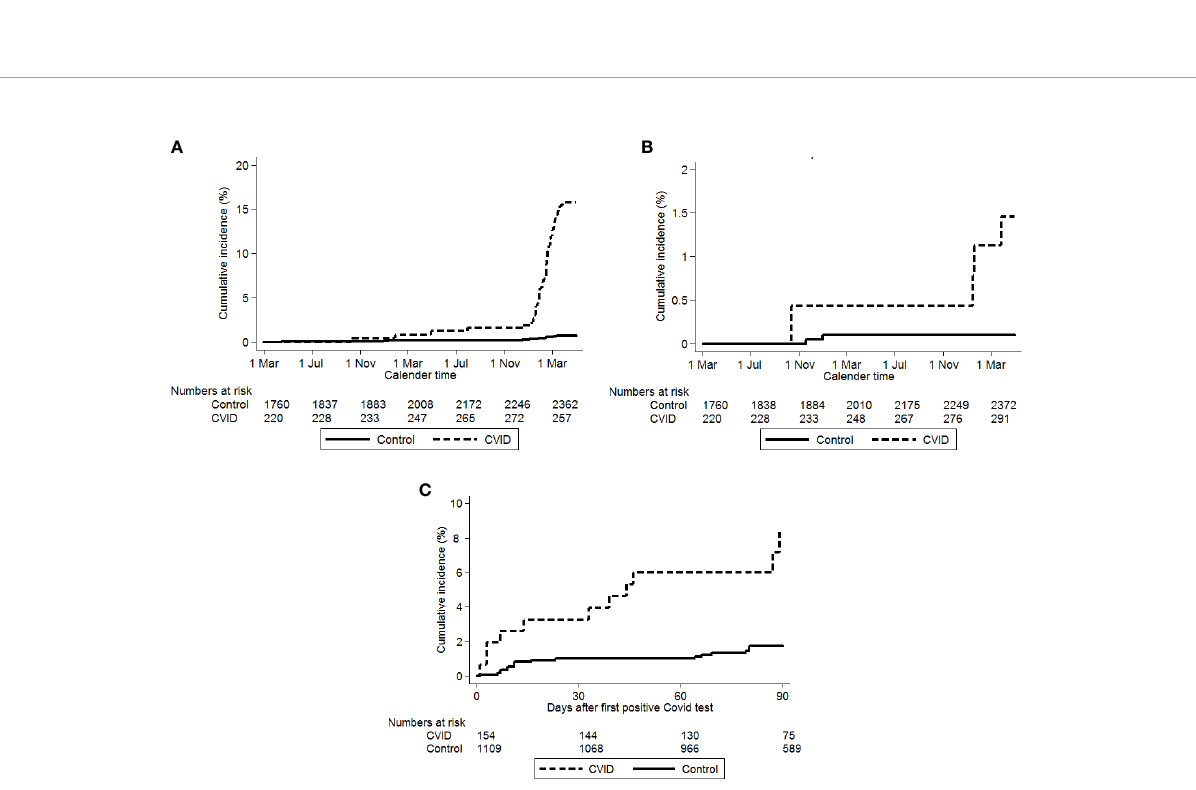
FIGURE 3 (A) First hospital contact with COVID-19. Solid line: population controls, dotted line: CVID patients. Time starts on 1 March 2020. (B) Time to fi rst hospitalizations with severe COVID-19, Solid line: population cointrol, dotted line: CVID patients. Time starts on 1 March 2020. (C) Time to hospitalization after the fi rst positive SARS-CoV-2 test. Solid line: population controls, dotted line: CVID patients. Time starts on date of fi rst positive SARS-CoV-2 test.